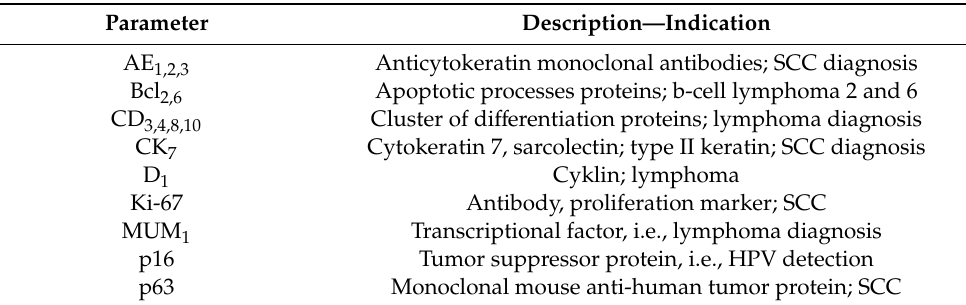
Table 2. IHC markers obtained in our